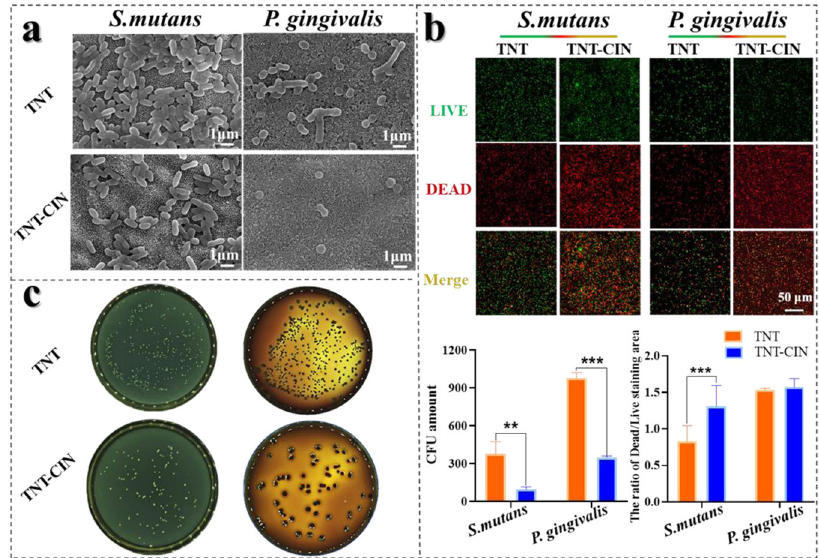
Fig. 6 TNT-CIN strongly resisted S. mutans and P. gingivalis . a Cells subjected to LIVE/DEAD staining observed by confocal microscope after culturing on different surfaces for 1 day and its semi- quantitative analysis. b S. mutans and P. gingivalis adhered on TNT and TNT-CIN after 1 day, as observed by SEM. c The viable S. mutans and P. gingivalis on different surfaces after 1 day (diluted 1000 folds) and its quantitative analysis. ** P < 0.01, *** P < 0.001.